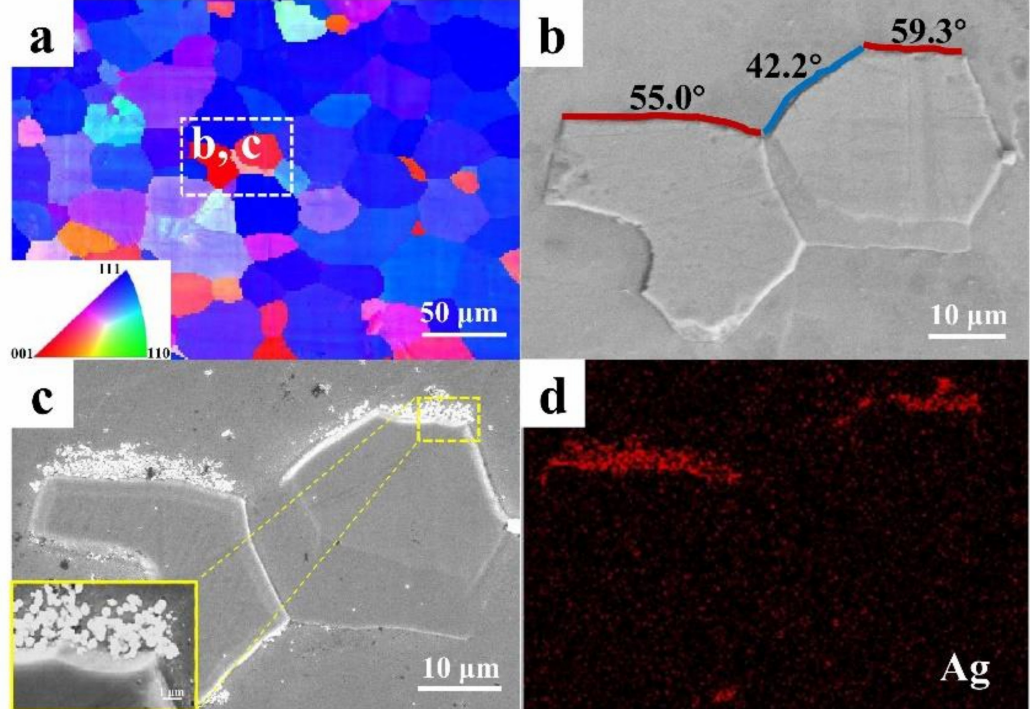
Figure 9. In situ HMT analysis of SEM and EBSD before ( a , b ) and after ( c , d ) hydrogen charging of the specimen; the white dotted box in ( a ) corresponds to ( b , c ); the numbers in ( b ) represent the misorientations of the GBs; the bottom-left in ( c ) is a locally magnified area; ( d ) surface distribution of